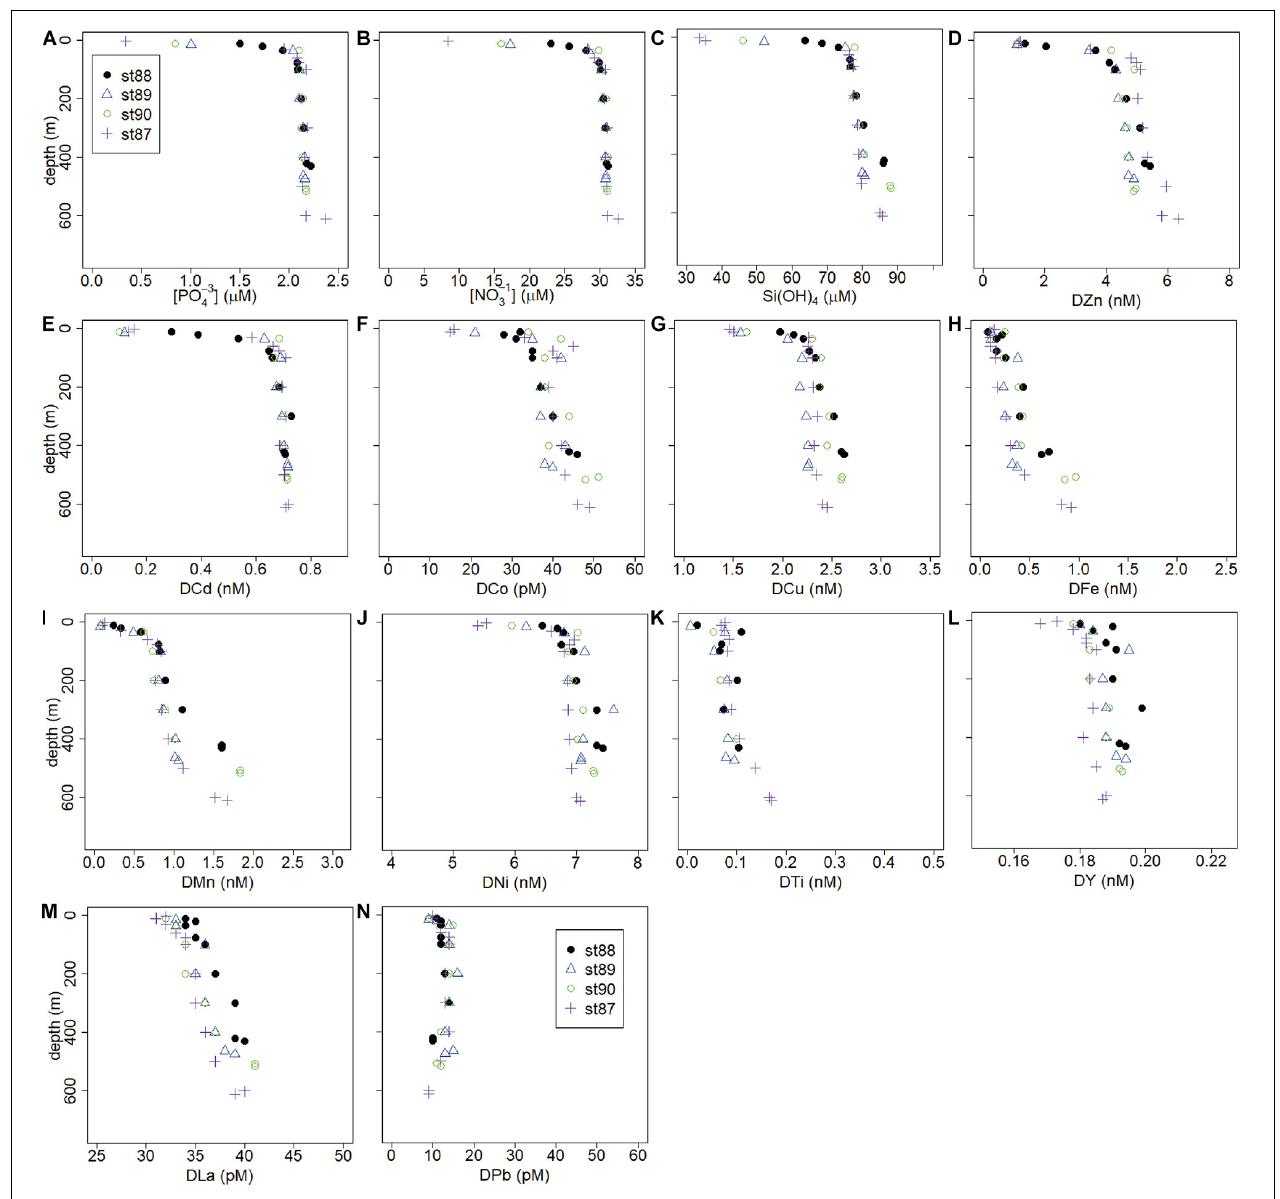
FIGURE 6 | Depth profiles of macro-nutrients ( µ M) and trace metals (nM or pM) of the Franklin Island transect, stations 88–90. (A) PO 43 − , (B) NO 3 − , (C) Si(OH) 4 , (D) DZn, (E) DCd, (F) DCo, (G) DCu, (H) DFe, (I) DMn, (J) DNi, (K) DTi, (L) DY, (M) DLa, (N)